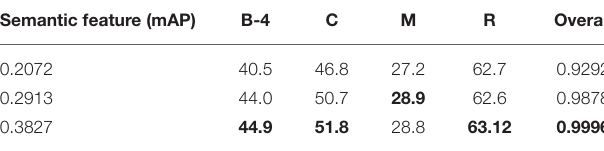
TABLE 4 | Results of scheduled sampling methods (multinomial sampling) on MSR-VTT data with different sets of semantic features.